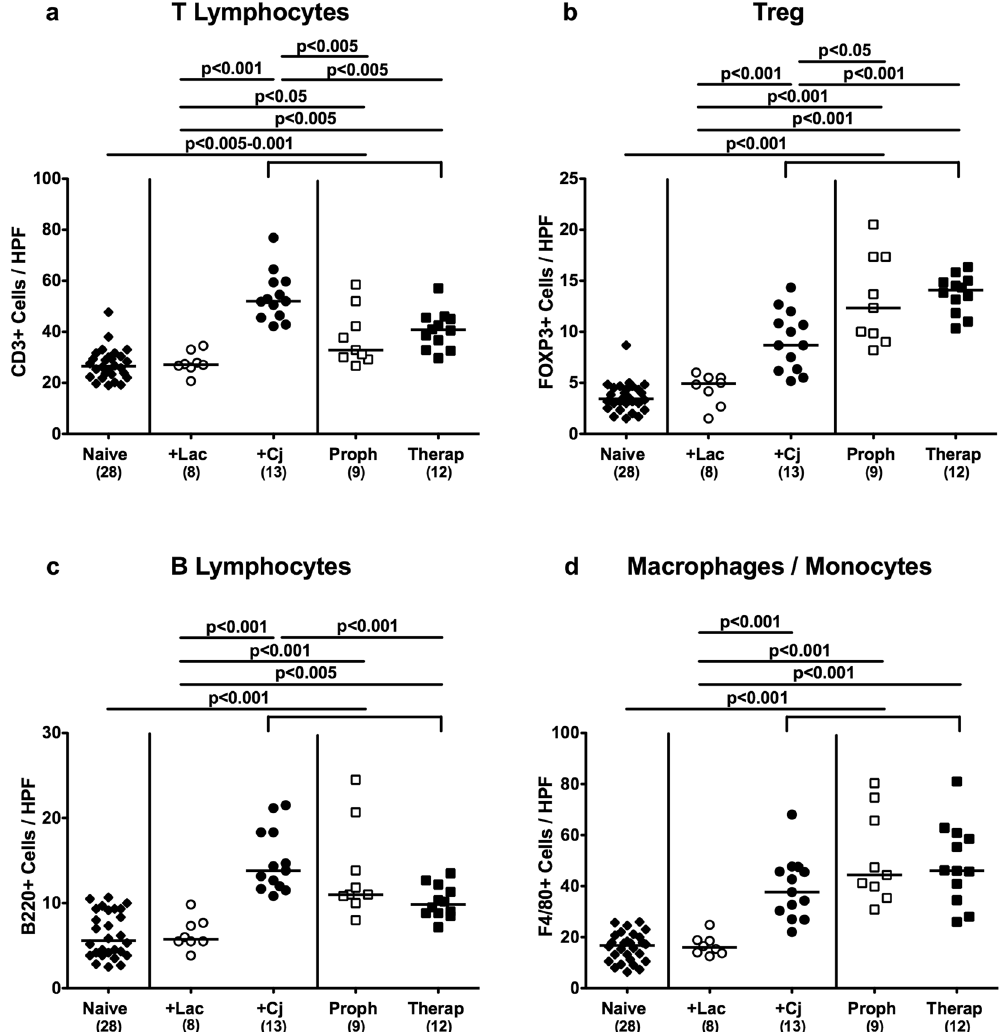
Figure 3. Colonic immune cell responses in C. jejuni strain 81–176 and/or L. johnsonii reassociated secondary abiotic mice. Secondary abiotic mice were perorally infected with C . jejuni strain 81–176 (Cj) and associated with L . johnsonii (Lac) either 14 days before (prophylactic regimen, Proph; white squares) or 7 days thereafter (therapeutic regimen, Therap; black squares) and compared to mono-associated mice ( + Lac, white circles; + Cj, black circles). The average number of colonic ( a ) T lymphocytes (positive for CD3), ( b ) regulatory T cells (Treg; positive for FOXP3), ( c ) B lymphocytes (positive for B220), and ( d ) macrophages and monocytes (positive for F4/80) from six high power fields (HPF, 400x magnification) per animal was determined microscopically in immunohistochemically stained colonic paraffin sections at days 21 or 28 following initial C . jejuni or L . johnsonii infection, respectively. Naive mice (black diamonds) served as uninfected controls. Medians (black bars), levels of significance (p-values) determined by one-way ANOVA test followed by Tukey post-correction test for multiple comparisons and numbers of analyzed animals (in parentheses) are indicated. Data were pooled from three independent